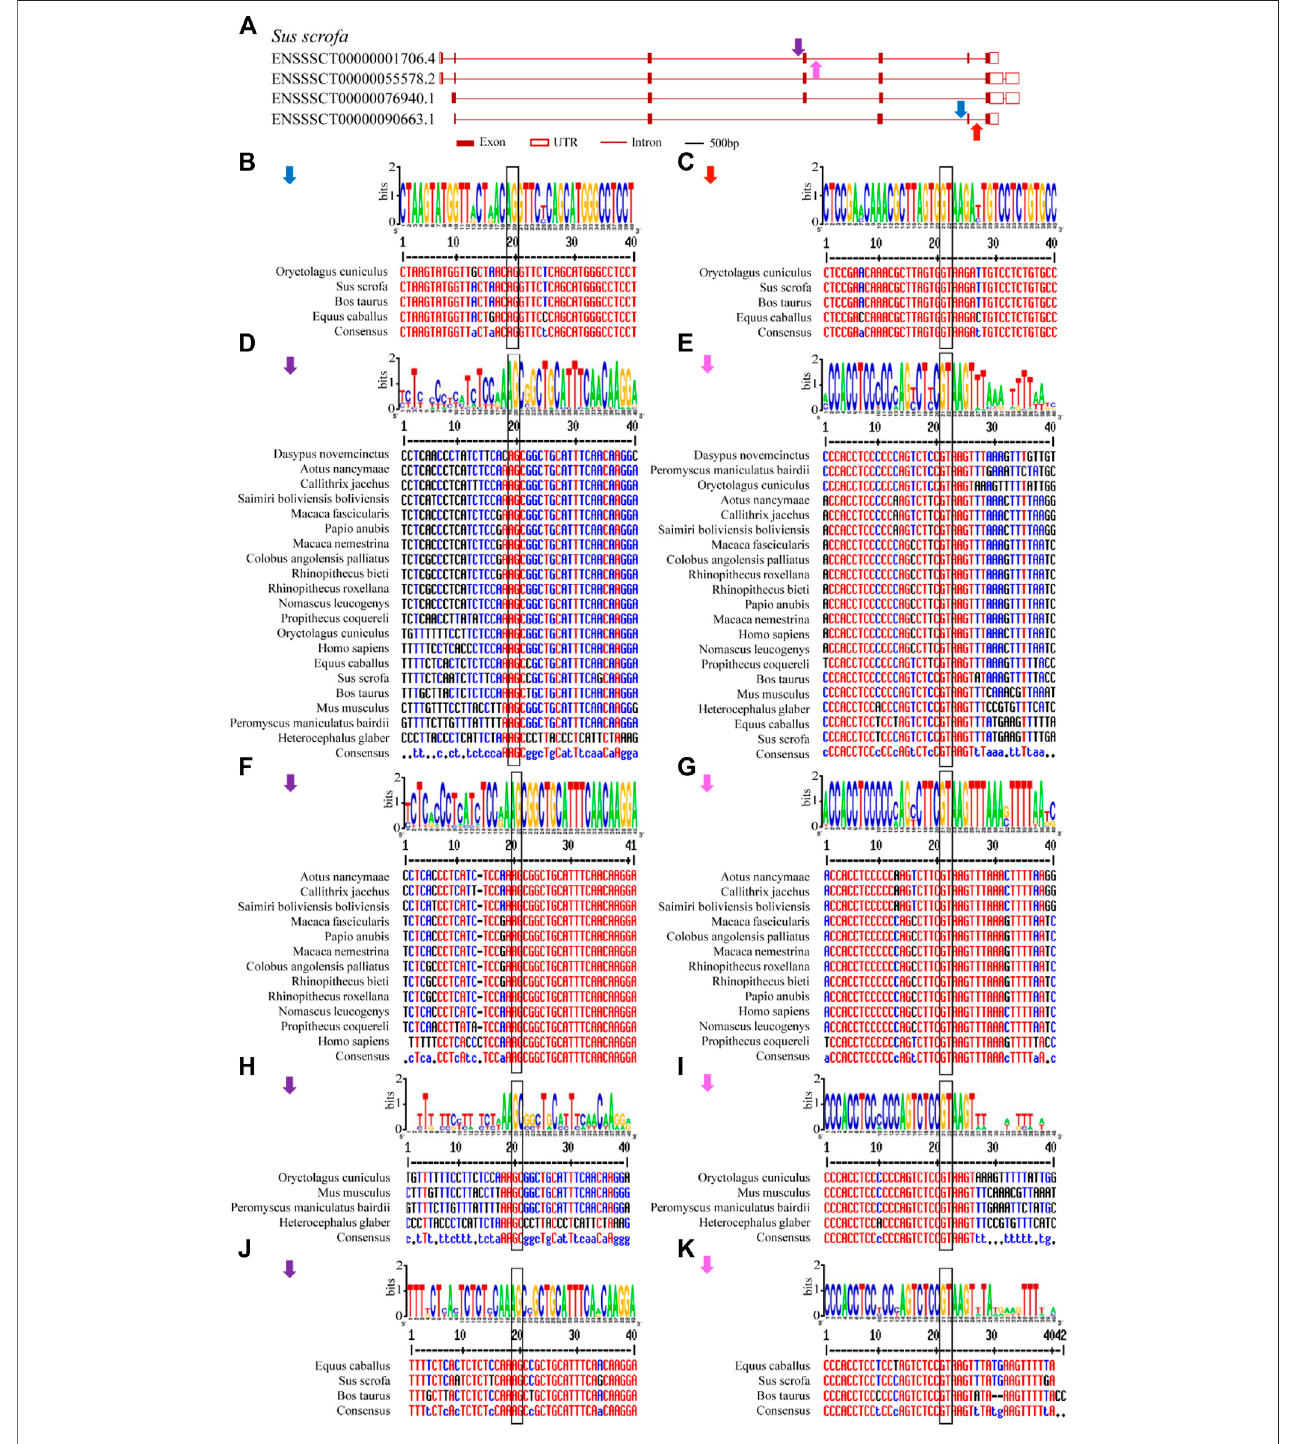
FIGURE5| Conservedalternativesplicesitesequencesanalysisforanimal U1C genes.Flankingsequences(40-bp)atconservedexon-intronboundariesofanimal U1C genes are analyzed to show their consensus by online Weblogo and multiple alignment. The conventional 5 ’ -GT or 3 ’ -AG splice site dinucleotides are marked in black rectangle. (A) Four conserved splice sites foundamong animal U1C gene ( Sus scrofa ) were marked inblue arrow (type 1), red arrow (type2), purple arrow (type 3) and pink arrow (type4). (B-E) represent graph representation andmultiple alignmentoftype1,type 2 , type 3and type 4conserved splice sites. (F,H,J) represent detailedanalysisoftype3splicesiteamongsector “ primates ” , “ rodentsandlagomorphs ” and “ OtherMammals ” . (G,I,K) representdetailedanalysisoftype4splicesite among sector “ primates ” , “ rodents and lagomorphs ” and “ Other Mammals ” . The label for the y-axis is “ bits ” . Red, blue and black of multiple sequence alignments represent high consensus (default value: 90%), low consensus (default value: 50 – 90%) and neutral, respectively.